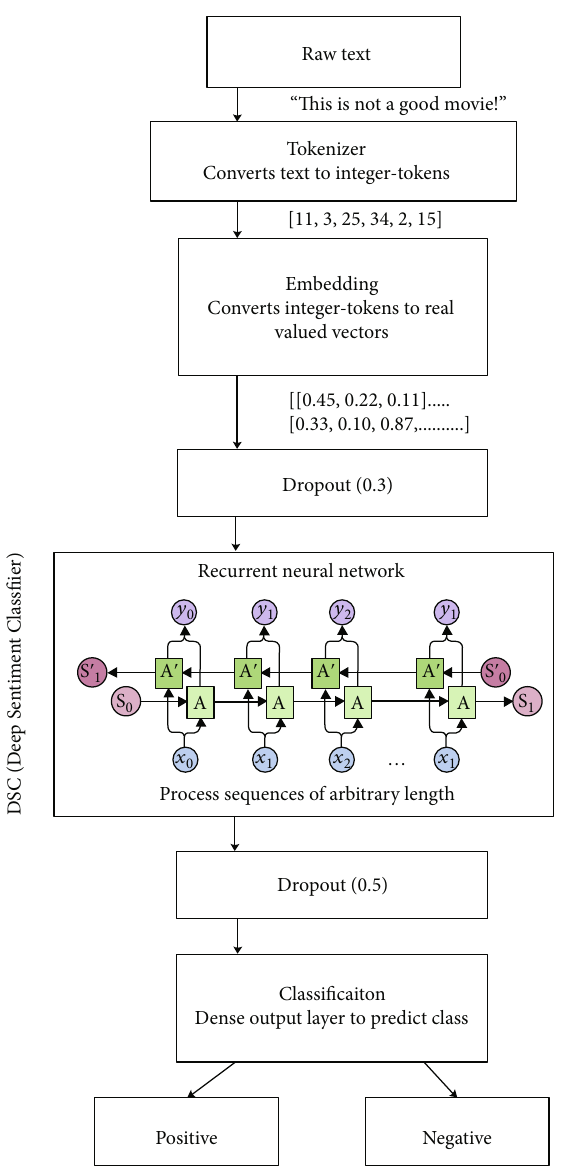
Figure 22: Deep sentiment classi fi er model. Table 8: Hyperparameters for the deep sentiment classi fi er. Hyperparameters